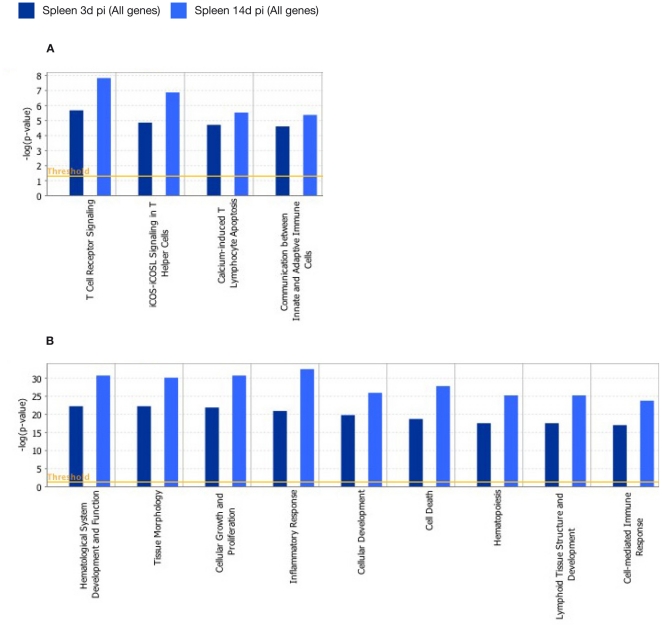
Functional networks (A) and canonical pathways (B) most significantly modulated in spleen cells 3 and 14 days after M. bovis infection.Visualization of the trend and significance in the regulation of each network and pathway are shown. Specific networks and pathways after 3 (dark blue bars) or 14 days p.i. (light blue bars) are indicated. Fisher's exact test threshold value of p≤0.05.